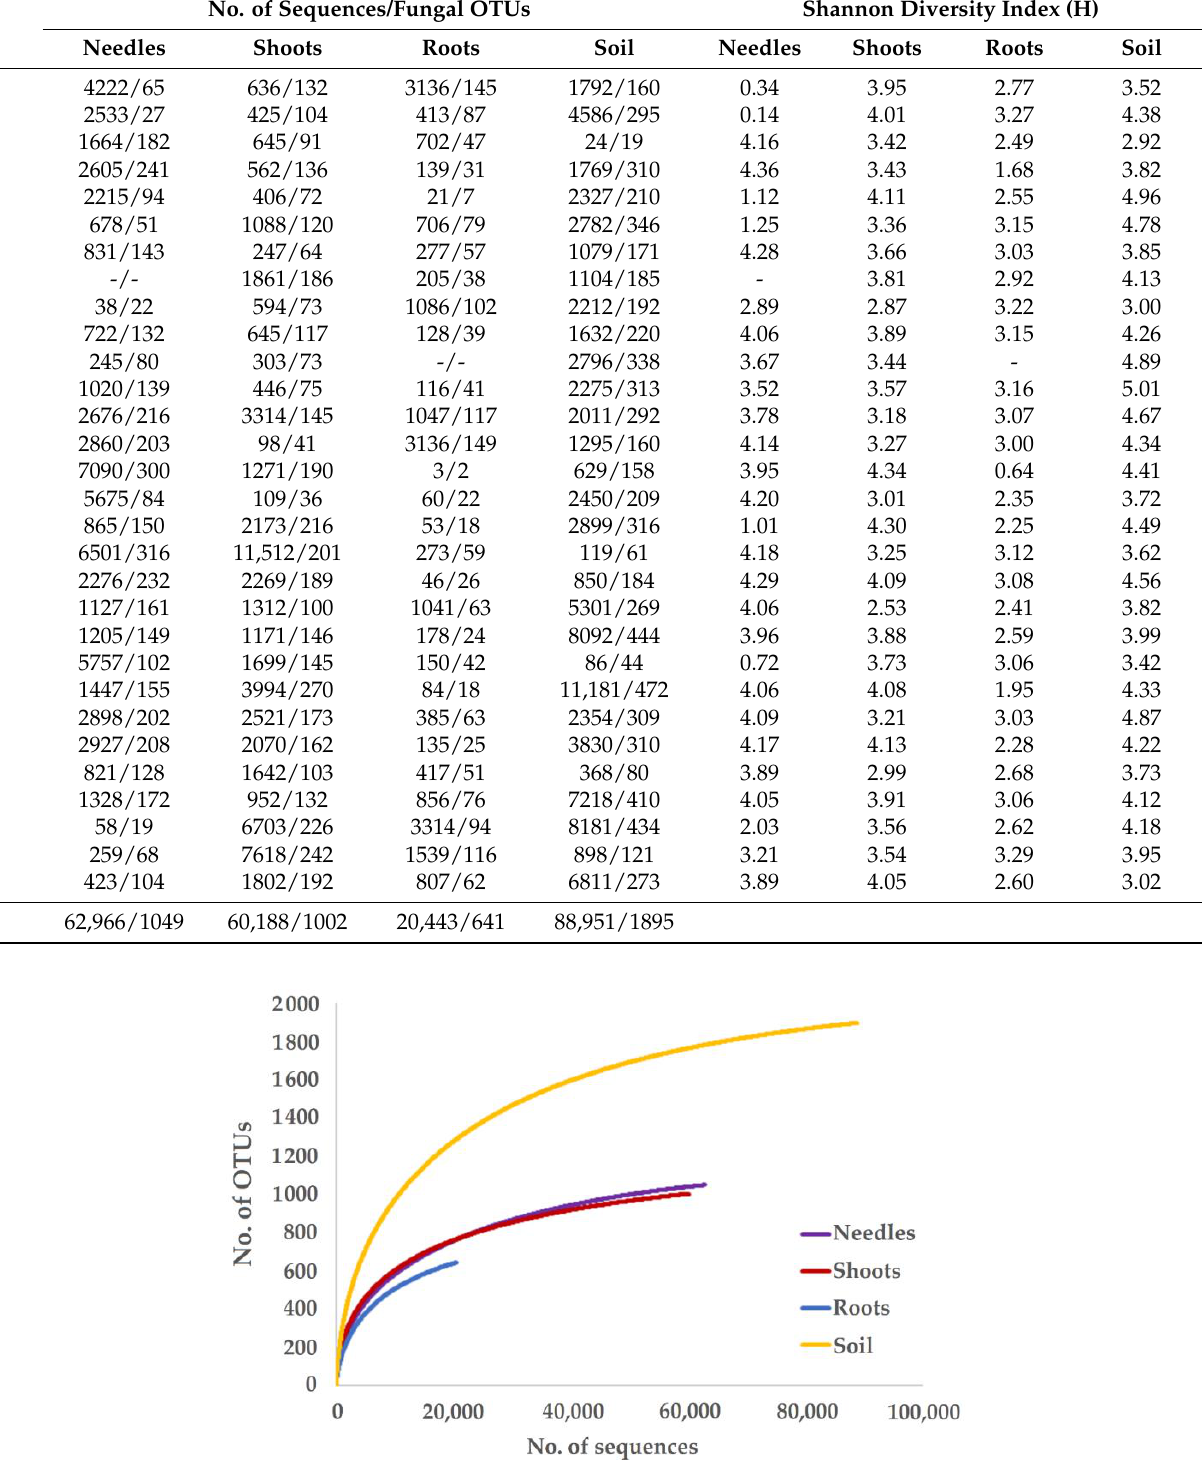
Figure 2. Rarefaction curves showing the relationship between the cumulative number of fungal OTUs and the number of ITS rRNA sequences in needles, shoots, roots, and the rhizosphere soil.